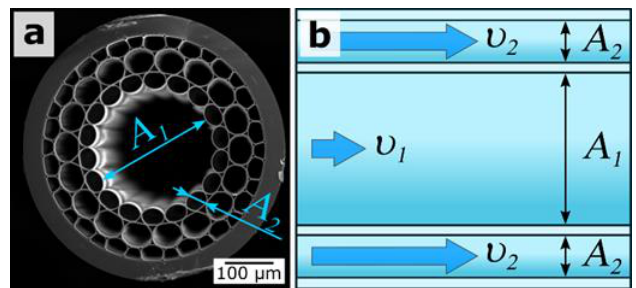
Figure 9. ( a ) SEM image of the MOW end face and ( b ) a schematic view of hollow core region surrounded by the smaller capillaries in the course of particle suspension deposition, A 1 and A 2 are the cross-sections of bigger and smaller capillaries, and υ 1 and υ 2 are the flow velocities inside the bigger and smaller capillaries, respectively.